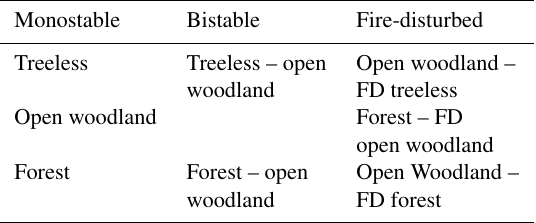
Table 3. Summary of possible vegetation states, divided as monos- table, bistable, and fire-disturbed. Fire-disturbed states have a higher fire regime than the indicated counterpart. Treeless always refers to TCF < 20%, open woodland to 20% ≤ TCF < 45%, and forest to TCF ≥ 45%. Monostable Bistable Fire-disturbed Treeless Treeless – open Open woodland – woodland FD treeless Open woodland Forest – FD open woodland Forest Forest – open Open Woodland – woodland FD